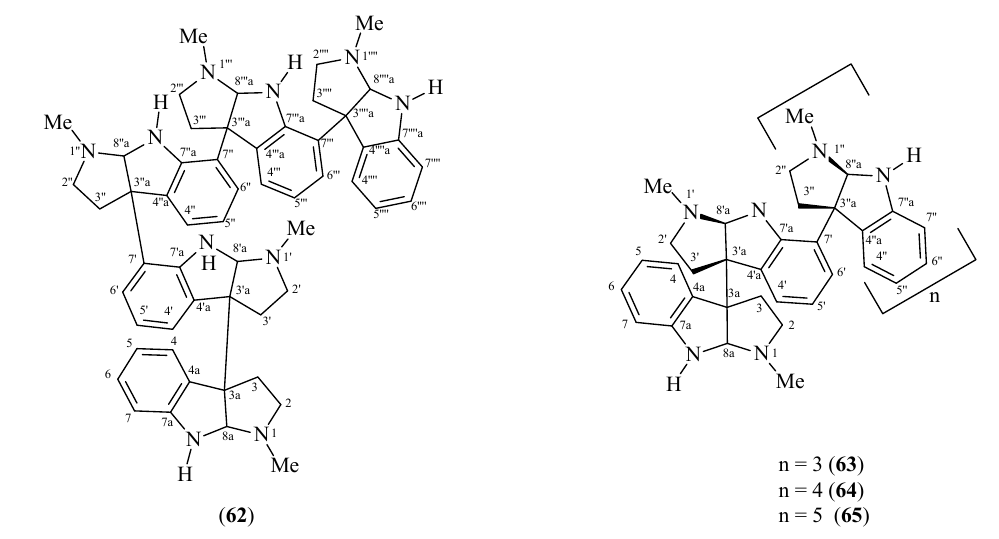
Figure 3. Structures of pyrrolidinoindoline alkaloids from Psychotria species. Table 4. 13 C-NMR data of pyrrolidinoindoline alkaloids from Psychotria species. Carbons